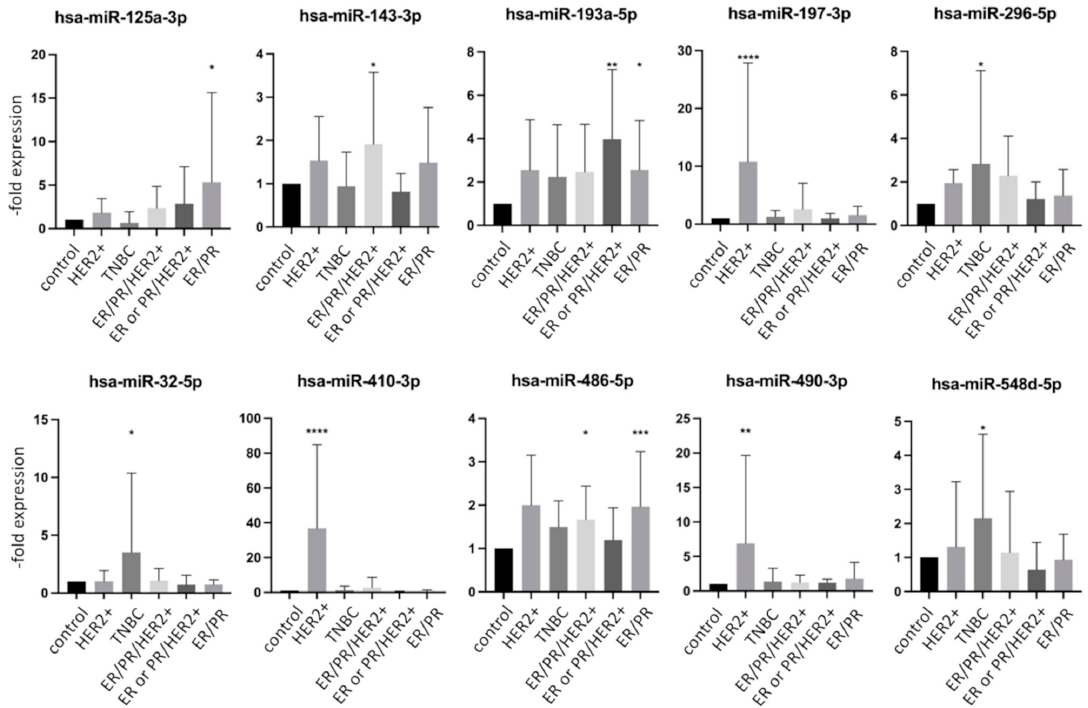
Figure 4. Expression levels of mostly upregulated miRNA in exosomes from healthy controls and breast cancer patients with or without metastases divided by tumor markers. Data are presented as mean values of fold expression over the control group with standard deviations, * p < 0.05, ** p < 0.01, *** p < 0.001, **** p < 0.0001.